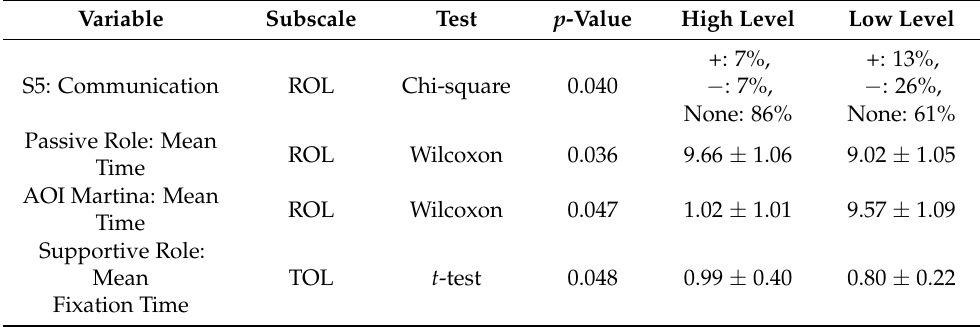
Table 5. Variables where statistically significant differences for ROL/TOL were found. The test